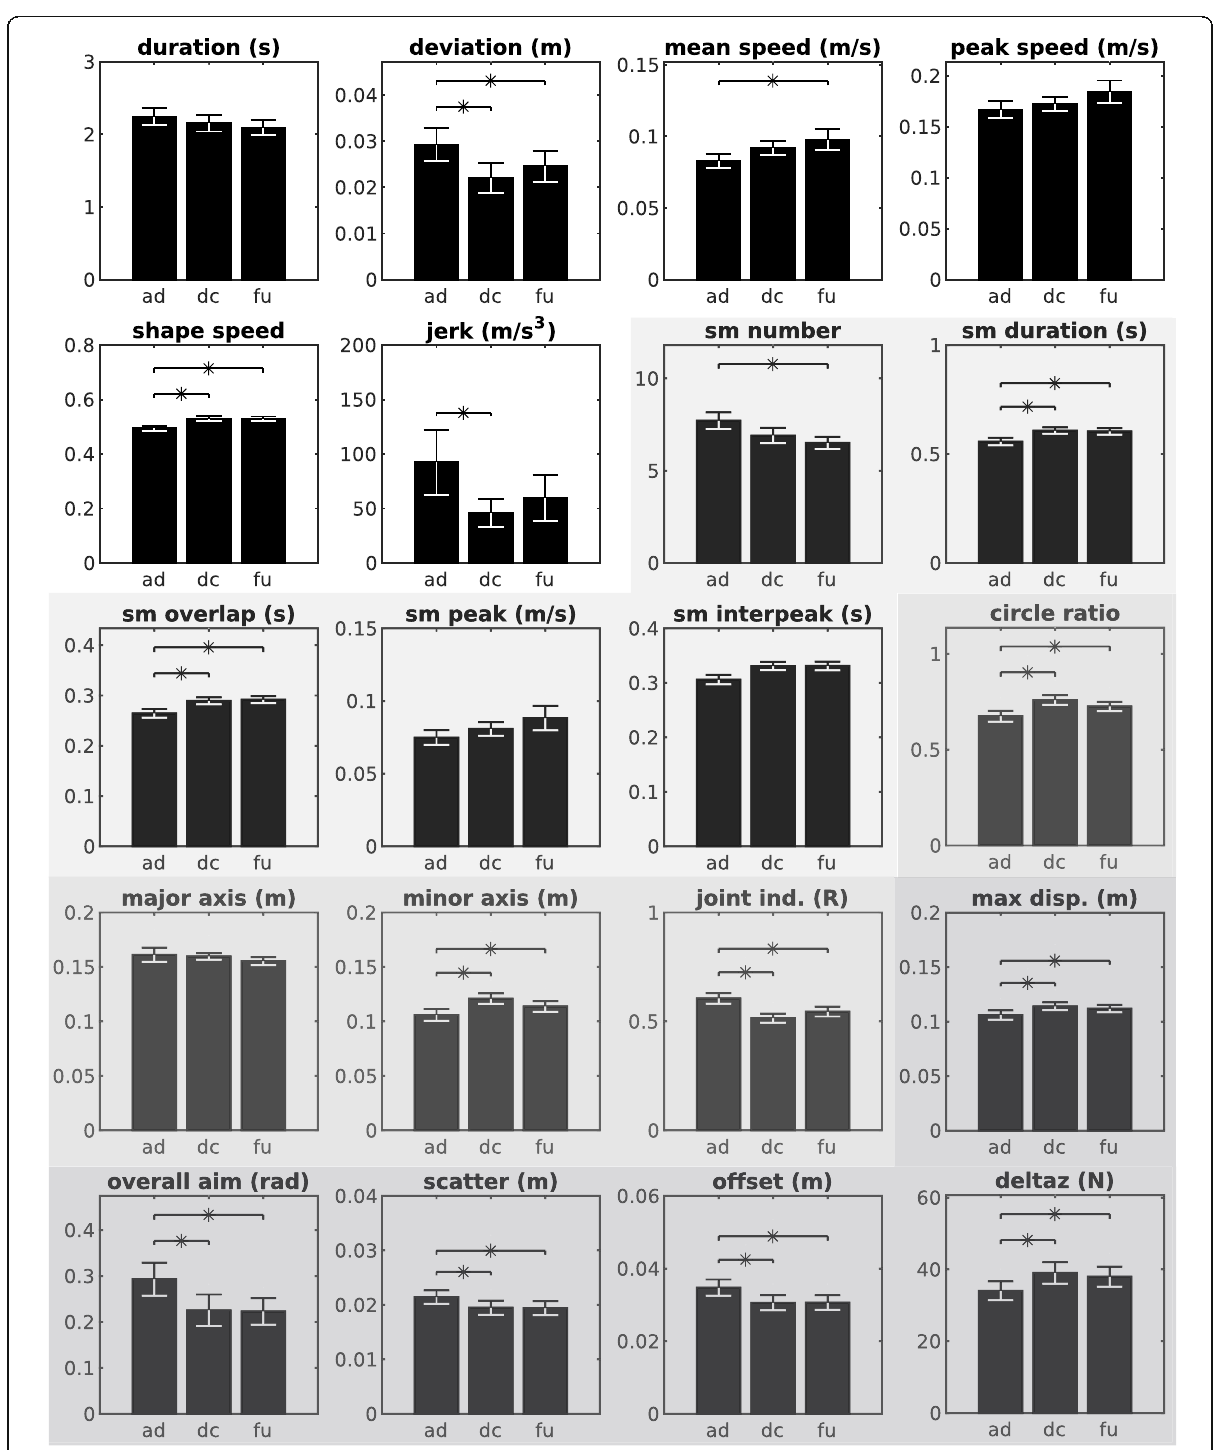
Fig. 2 Combined Robot tDCS and Robot Sham mean and standard error of kinematic and kinetic outcome metrics for the shoulder-elbow (S/E.) Significant changes ( P < .0167) between admission (ad), discharge (dc), and follow-up (fu.) are marked with an * Note: The bar-graphs in white background represent the unconstrained trained reaching macro-metrics, the lightest grey shading background represents the unconstrained trained reaching micro-metrics (sm= sub-movement), the slightly darker grey represents the unconstrained untrained circle metrics, and the darkest grey represents the reaching against resistance, isometric stabilization, and kinetic metrics (respectively, see Additional file 1 for further details on the